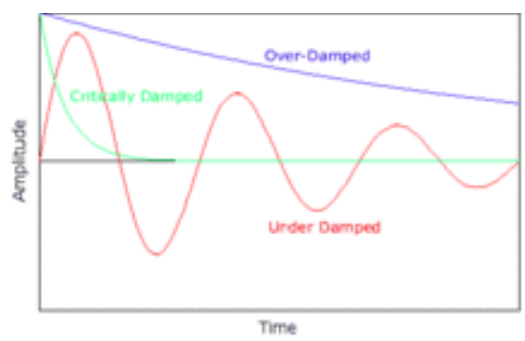
Figure 7 Different damping motions representation 3